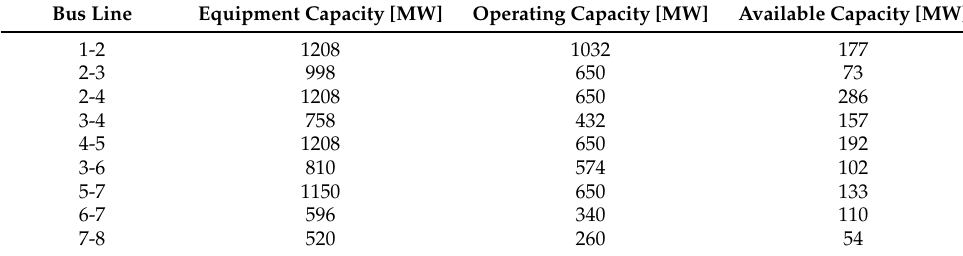
Table 3. Power line